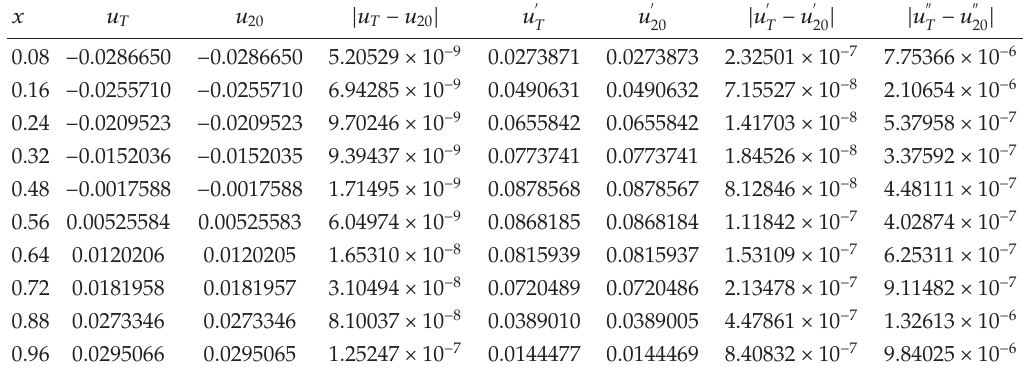
Table 6: The numerical results of Example 3.4, p (cid:9) q (cid:9) β (cid:9) 1 , α (cid:9) 2 , k (cid:9) 2 , n (cid:9) 20.